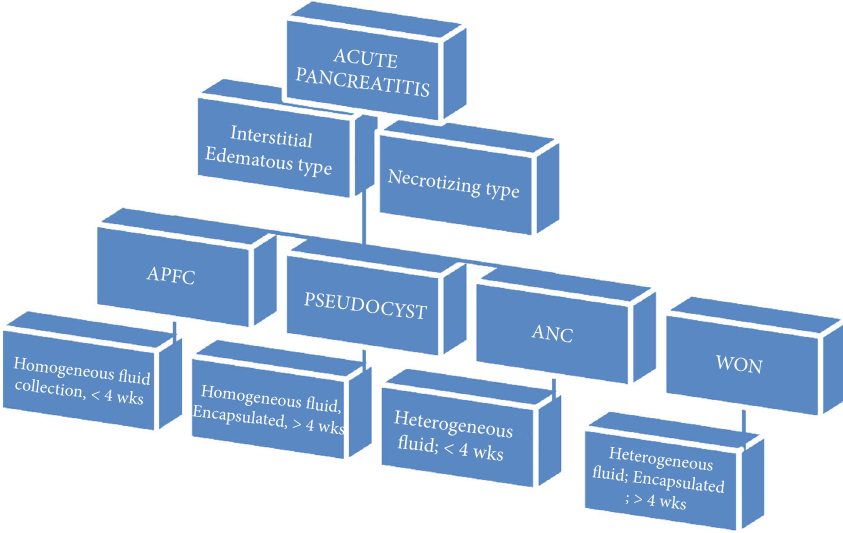
Figure 1: Revised Atlanta classi fi cation system of acute